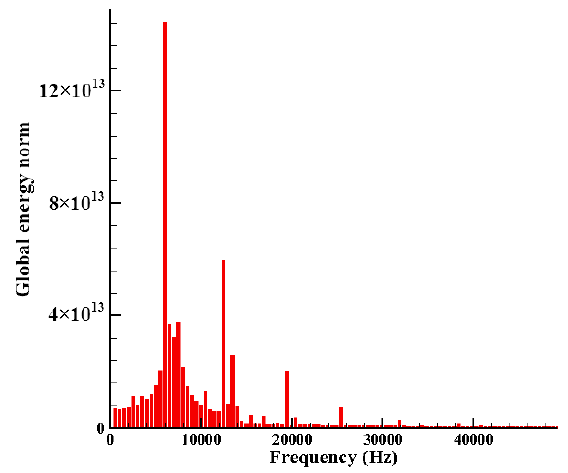
Figure 5. DMD spectrum of uncontrolled compressor.